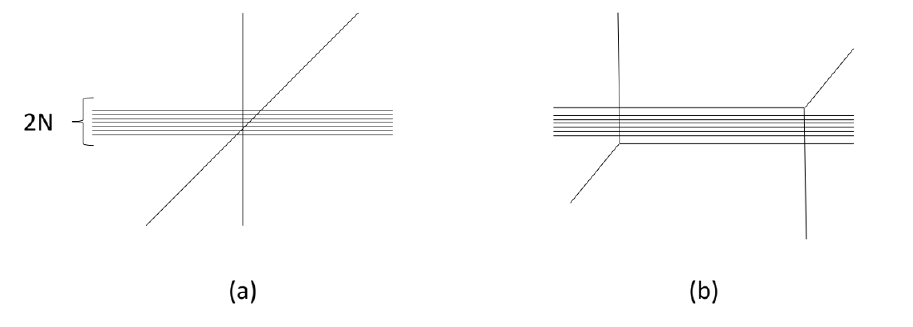
Figure 3 . (a) The brane web for a 5d SCFT with global symmetry SU(4 N ) (cid:2) U(1) 2 . (b) The same web after moving some of the 7-branes. This corresponds to a mass deformation of the 5d SCFT. As can be seen from the web, this mass deformation sends the 5d SCFT to an SU(2 N + 1) gauge theory with 4 N (cid:13)avors in the fundamental